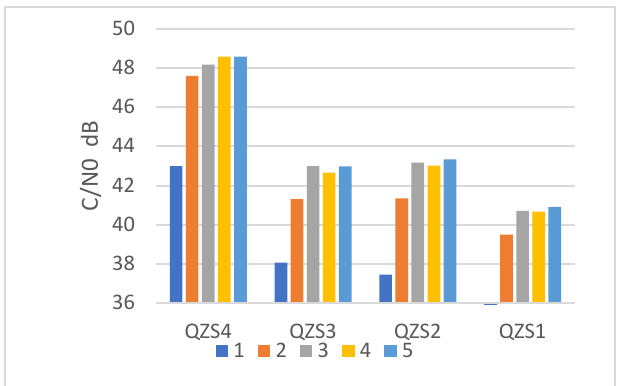
Figure 15. The estimated value of C/N0 in different tracking modes for the L1C.